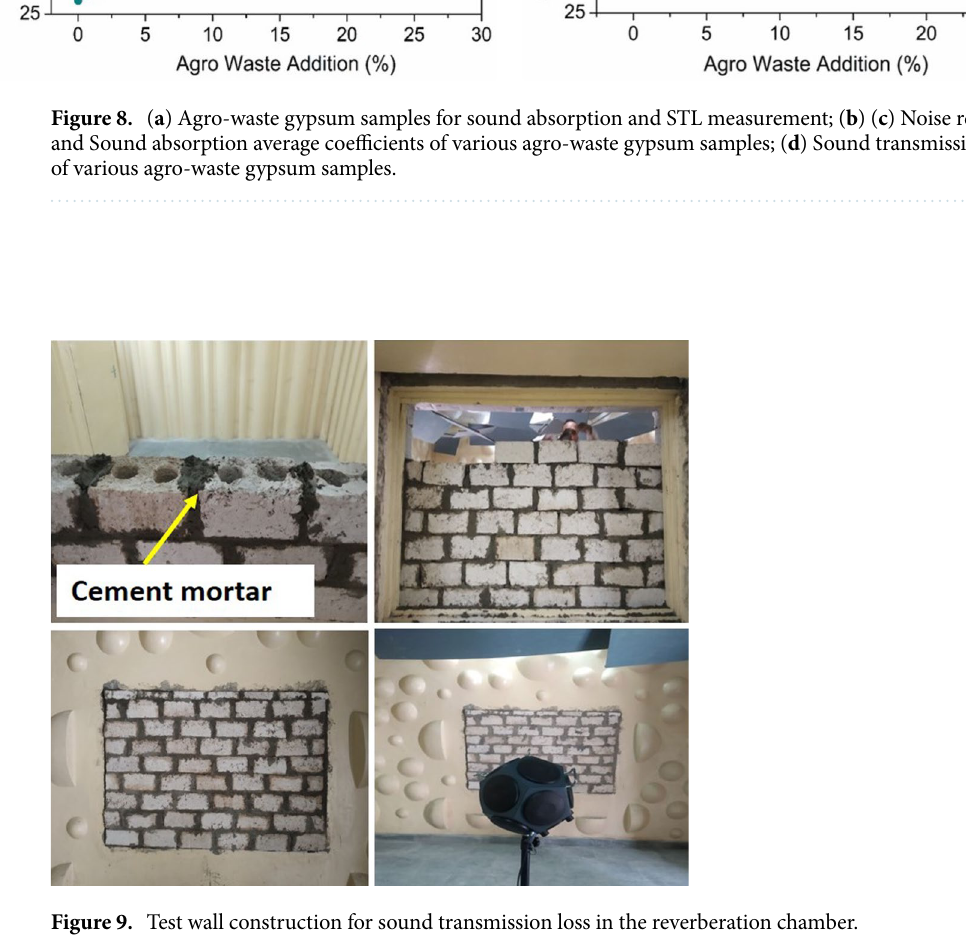
Figure 9. Test wall construction for sound transmission loss in the reverberation